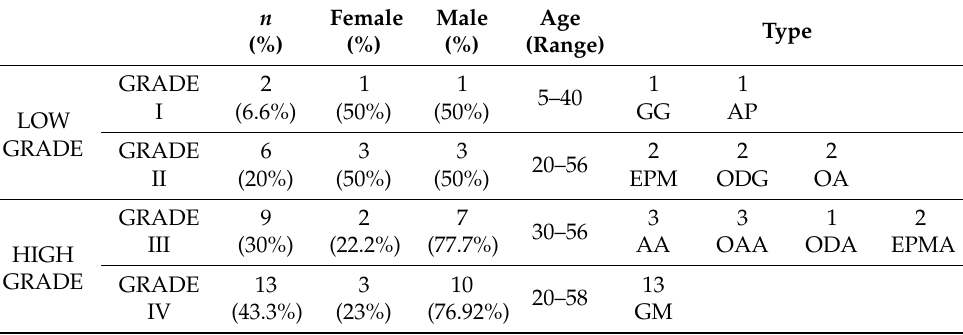
Table 2. Frequencies of characteristics of the population with high- and low-grade gliomas. GG: ganglioglioma; AP: Pilocytic Astrocytoma; EPM: Ependymoma; ODG: Oligodendroglioma; OA: Oligoastrocytoma; AA: Anaplastic Astrocytoma; OAA: Anaplastic oligoastrocytoma; ODA: Oligodendroglioma anaplastic; EPMA: Ependymoma anaplastic; GM: glioblastoma multiforme.